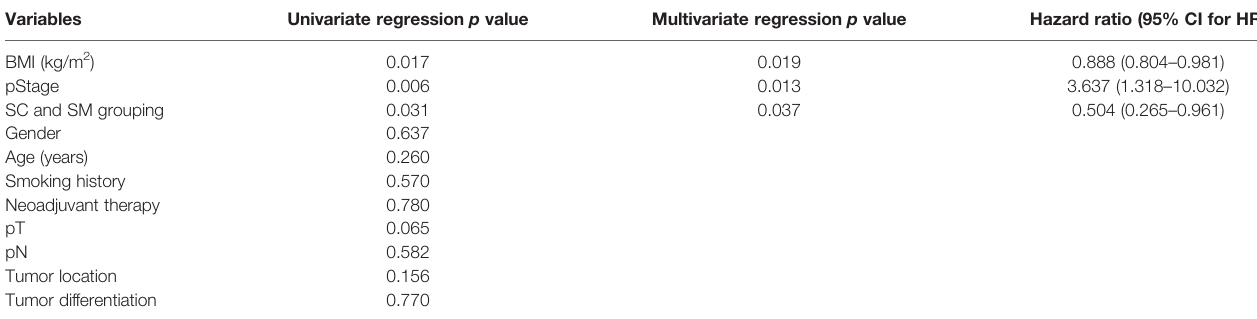
TABLE 3 | DSS differences after multivariate Cox proportional hazards regression analysis for the matched patients.